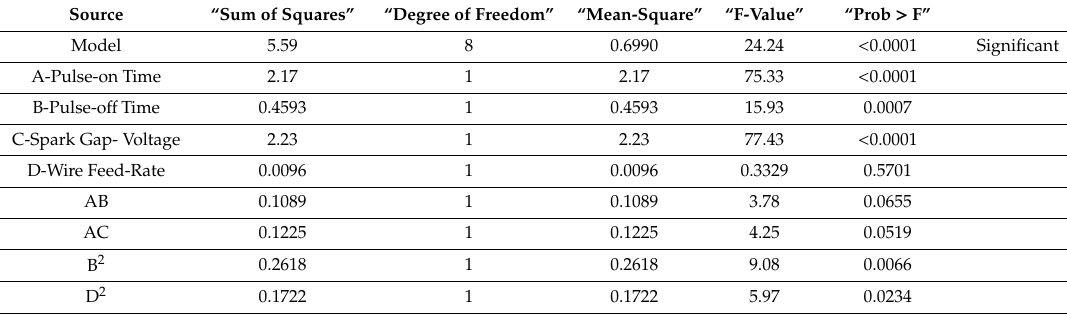
Table 6. ANOVA test results for